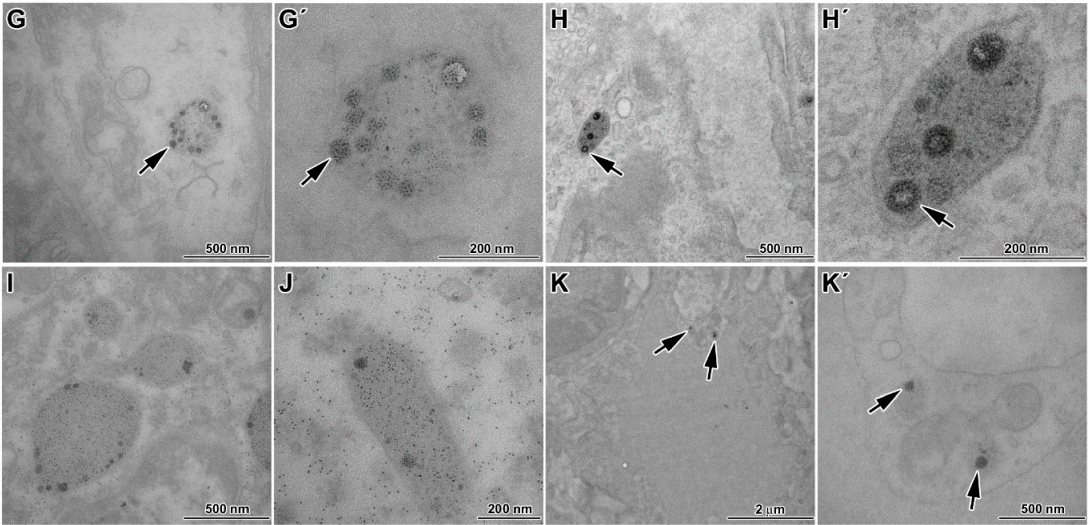
Figure 2. Ultracellular changes in lung tissue following six weeks exposure to CdO nanoparticles: ( A ) bronchiole in control sample; ( B ) bronchiole after treatment with signs of inflammation, neutrophils (n), erythrocytes (e) and cell debris (cd) present in lumen of bronchiole; ( C , C ′ ) bronchiolar epithelium with vesicle full of different sized cadmium nanoparticles; ( D ) alveoli in control sample; ( E , E ′ ) alveoli after treatment are completely filled with nanoparticles; ( F ) in alveoli, higher amount of surfactant (s) and impaired alveolar macrophage (m) is obvious; ( G , G ′ , H , H ′ ) cadmium nanoparticles in vesicles of alveolar epithelial cells type I; ( I , J ) cadmium nanoparticles in phagosomes of pulmonary macrophage; and ( K , K ′ ) cadmium nanoparticles in vesicles of capillary endothelial cell. Arrows show nanoparticles.